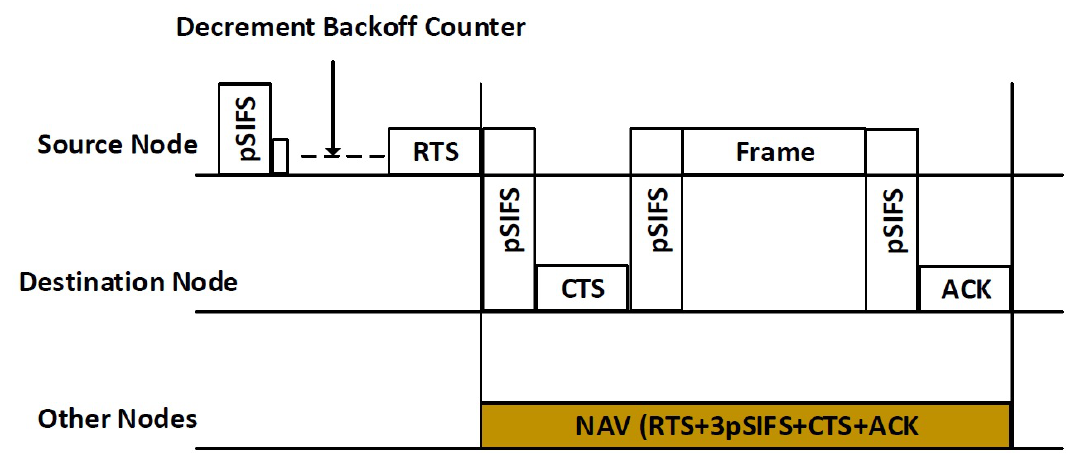
Figure 4. RTS/CTS scheme between two nodes in IEEE 802.15.6 CSMA/CA based